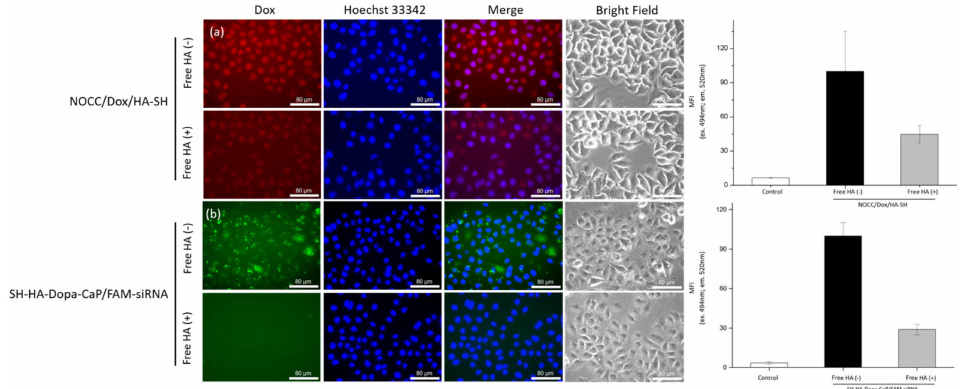
Figure 8. In vitro intracellular uptake of ( a ) NOCC/Dox/HA-SH and ( b ) SH-HA-Dopa-CaP/FAM- siRNA NPs after 30 min in the absence and presence of free HA (10